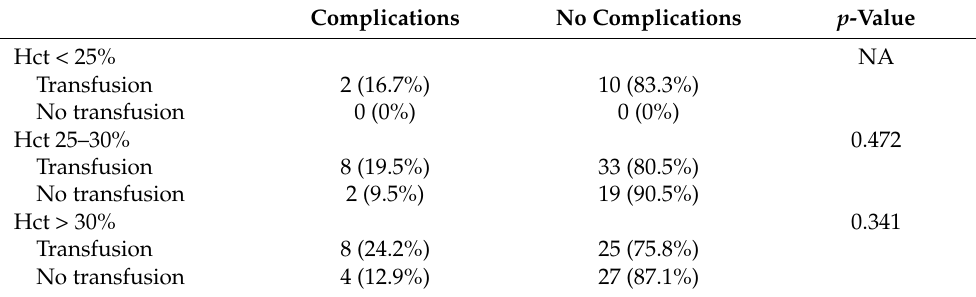
Table 3. Subgroup analysis of incidence of complications between transfusion and non-transfusion groups for different hematocrit